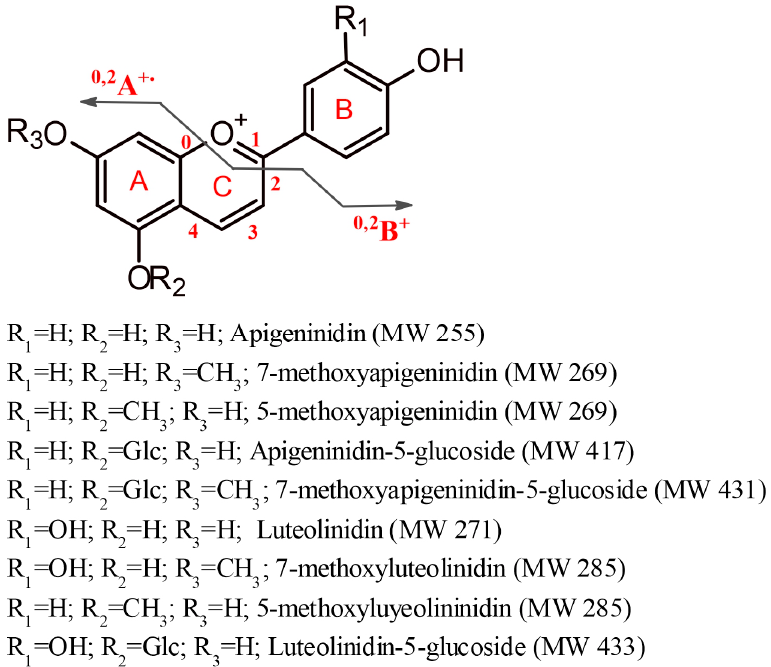
Figure 1. Chemical structures and molecular weights of 3-DXA and derivatives present in red sorghum. Nomenclature and two characteristics fragment ions of anthocyanins are also illustrated in the figure.